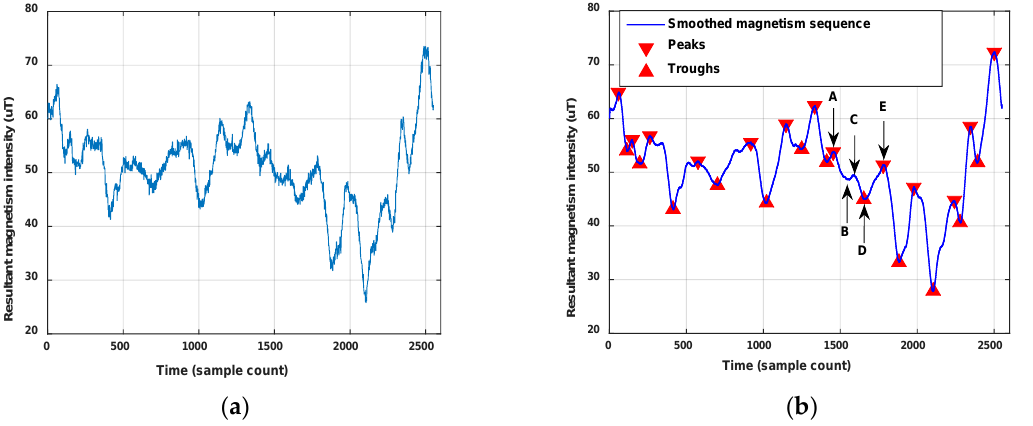
Figure 11. Example for magnetism feature extraction: ( a ) sequence of resultant magnetism intensity generated with a user trace; ( b ) feature extraction result.